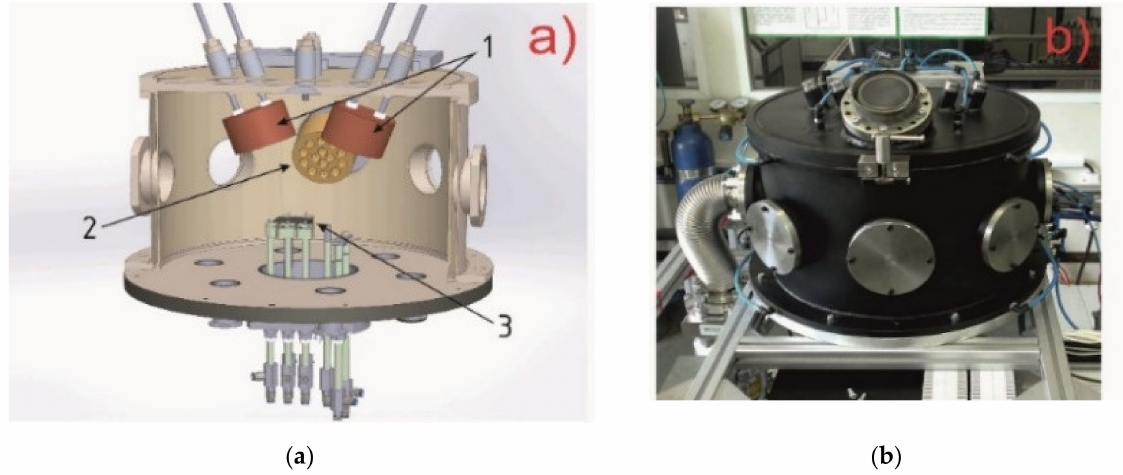
Figure 1. Scheme ( a ) and external view ( b ) of the ion-plasma installation: 1—magnetron-sputtering systems; 2—ion source with closed electron drift; 3—substrate holder with heating function.